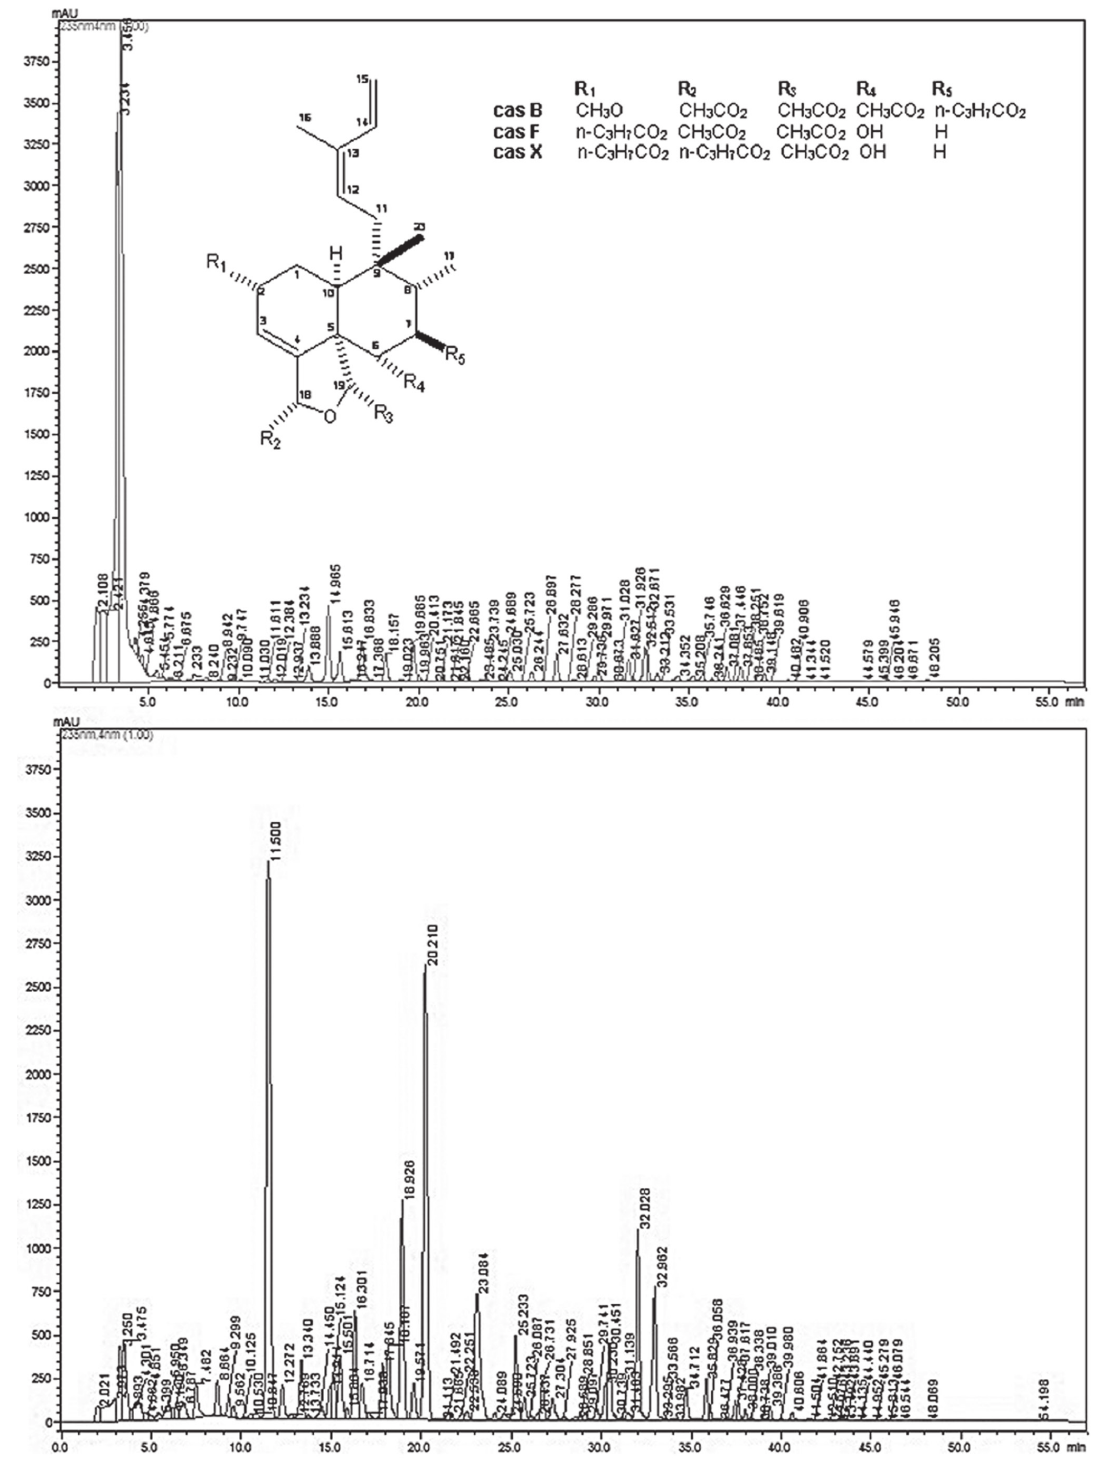
Figure 5 - Representative high performance liquid chromatography (C18; methanol: acetonitrile: water gradient; 235 nm) profile of extracts from leaves of C. sylvestris - specimens AGS38 var. lingua (top) and AGS101 var. sylvestris (bottom). Structures of diterpenes standards are presented: caseargrewiin F (cas F), casearins B and X (cas B and cas